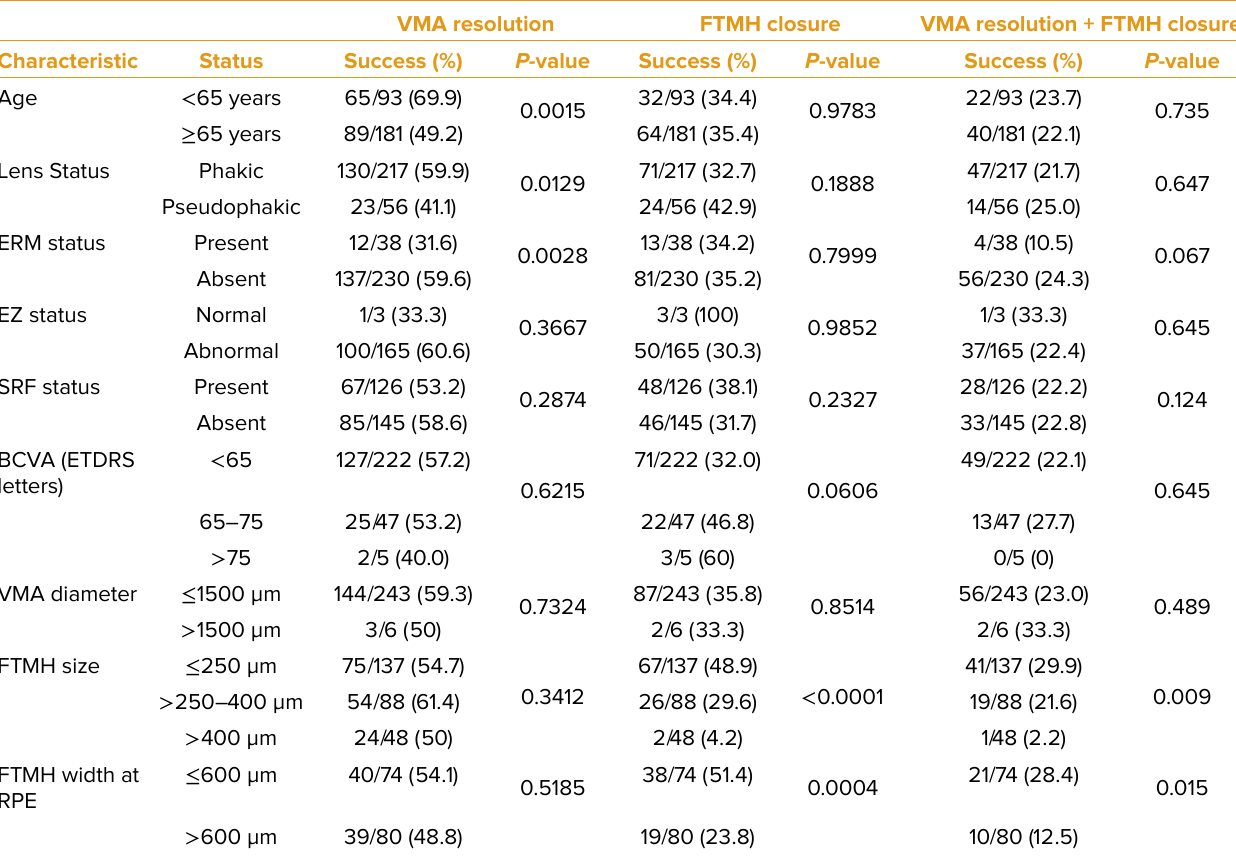
Table 3. Univariable logistic regression analysis for the effect of patient demographics and ocular baseline characteristics on VMA resolution by Day 28 and FTMH closure by Month 6 in the integrated dataset VMA resolution FTMH